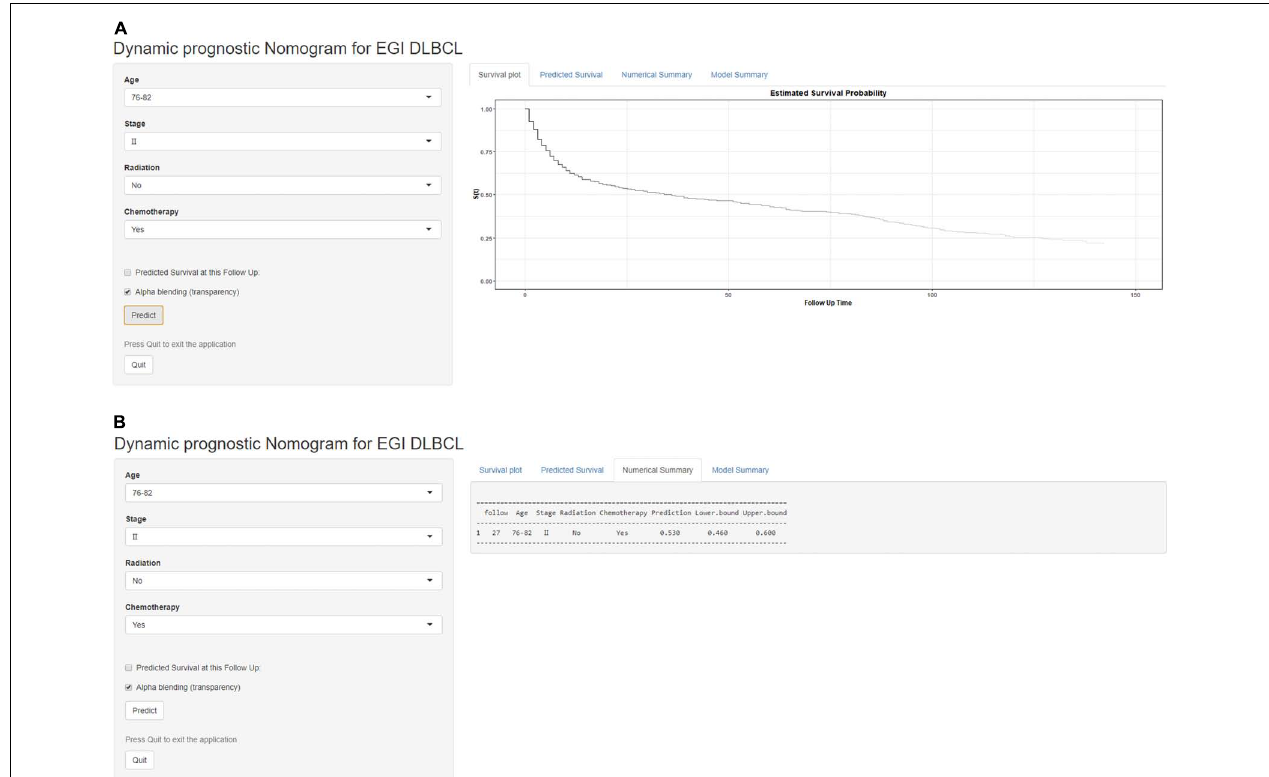
FIGURE 2 | A web-based dynamic prognostic nomogram for overall survival (OS) estimation in elderly patients with primary gastrointestinal diffuse large B-cell lymphoma (EGI DLBCL). (A) Patient with an Ann Arbor stage of III, age at 76–82 years, no radiation, who received chemotherapy according to the web survival rate calculator (95% CI 46–60%). (B) 95% confidence interval (CI) according to the web survival rate